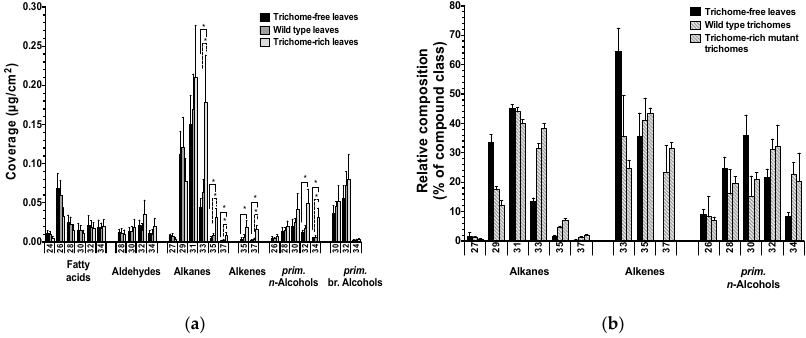
Figure 5. Wax composition of Arabidopsis leaves and isolated trichomes. ( a ) Coverage of single wax compounds within each compound class on leaves of the trichome-free mutant gl1 , the wild type, and the trichome-rich mutant cpc tcl1 etc1 etc3 . ( b ) Relative distributions of single compounds within each compound class on leaves of the trichome-free mutant gl1 , on trichomes isolated from wild type leaves, and on trichomes isolated from trichome-rich mutant leaves. Average values are given with standard deviations ( n = 5). The x-axis labels indicate the total carbon chain numbers of compounds. Asterisks indicate discovery of significant differences between coverages based on Student’s t -test (* = p < 0.05) (adapted from [6]).